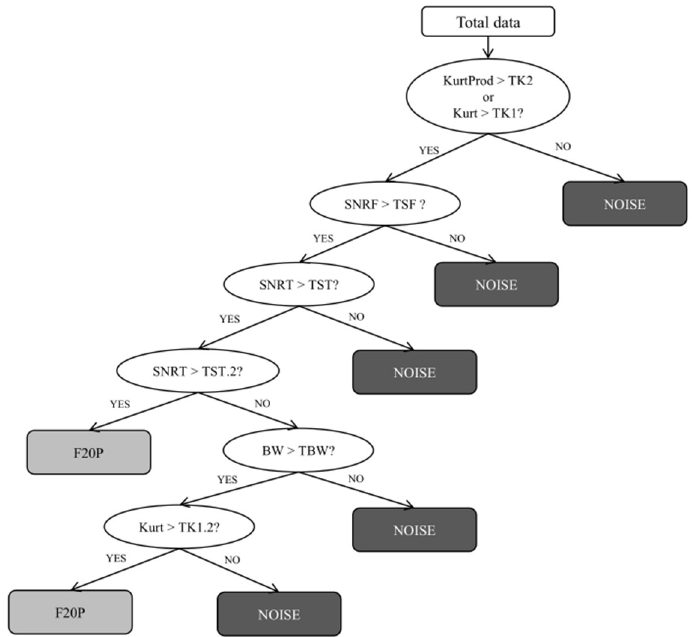
Figure 4. Decision tree representation of the applied thresholds (i.e., TK1, TK2, TSF, TST, TST.2, TBW, and TK1.2) to the five metrics of each detection (i.e., KurtProd, Kurt, SNR F , SNR T , and BW).